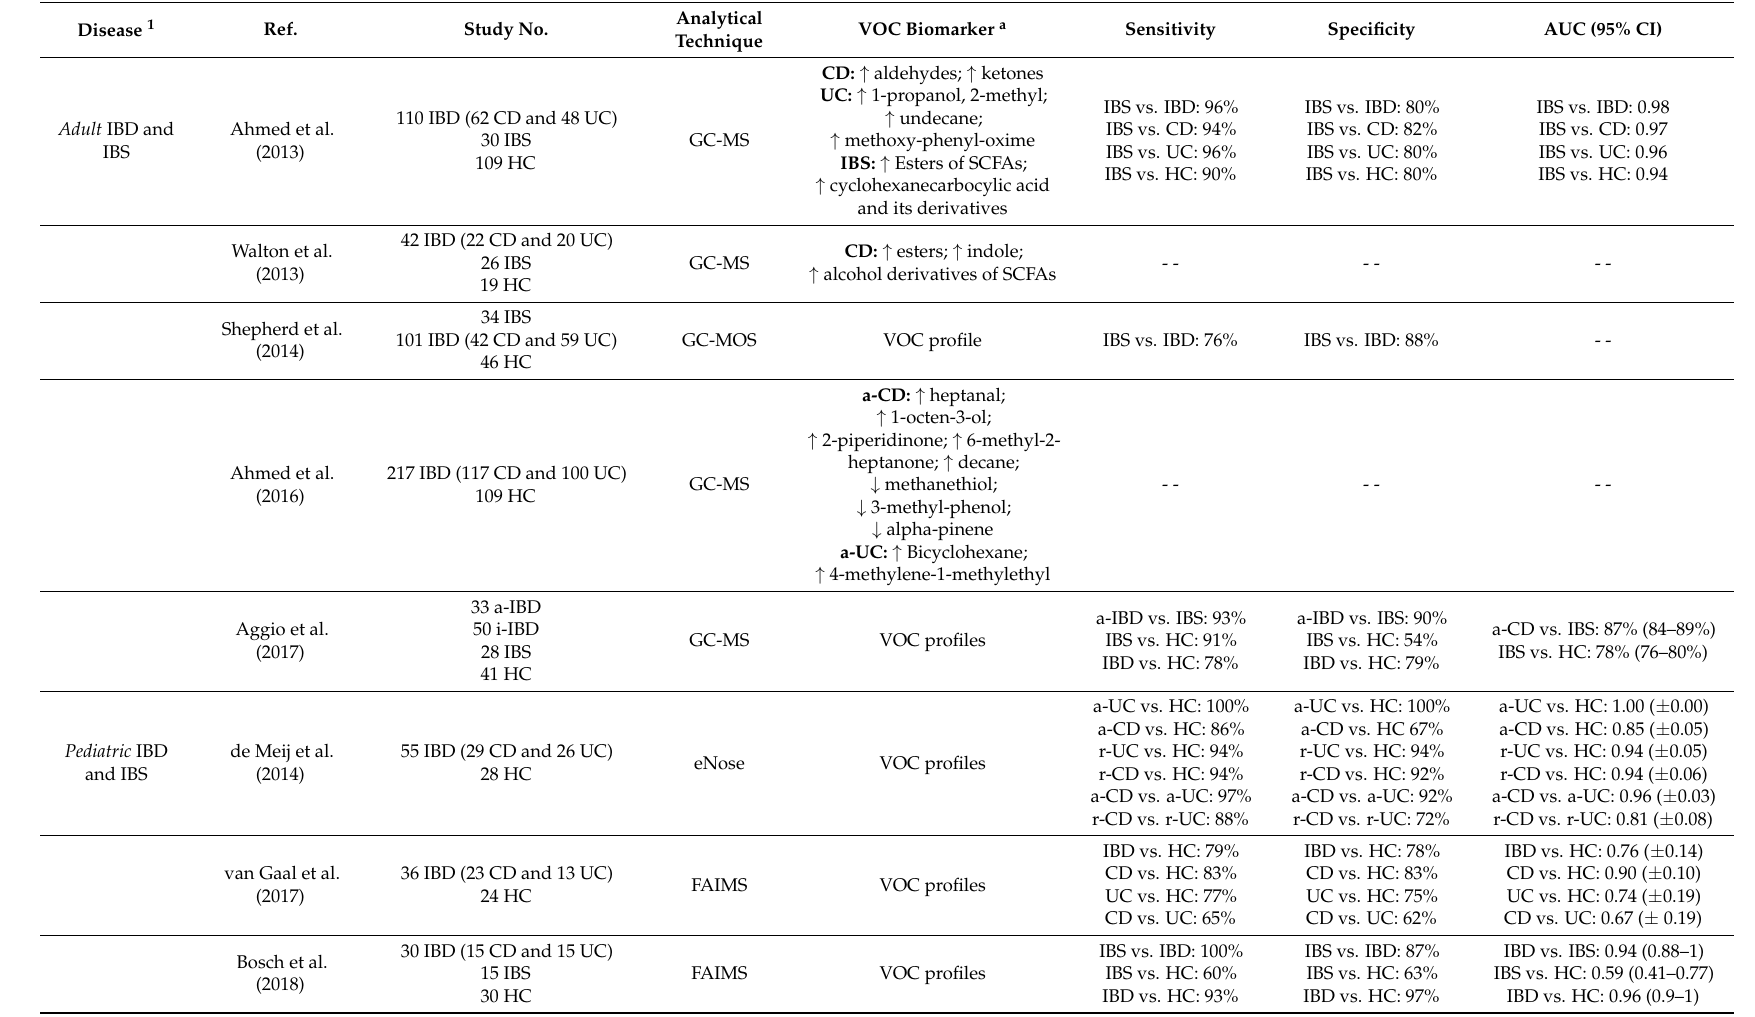
Table 3. Overview of studies on fecal VOC analysis in gastrointestinal